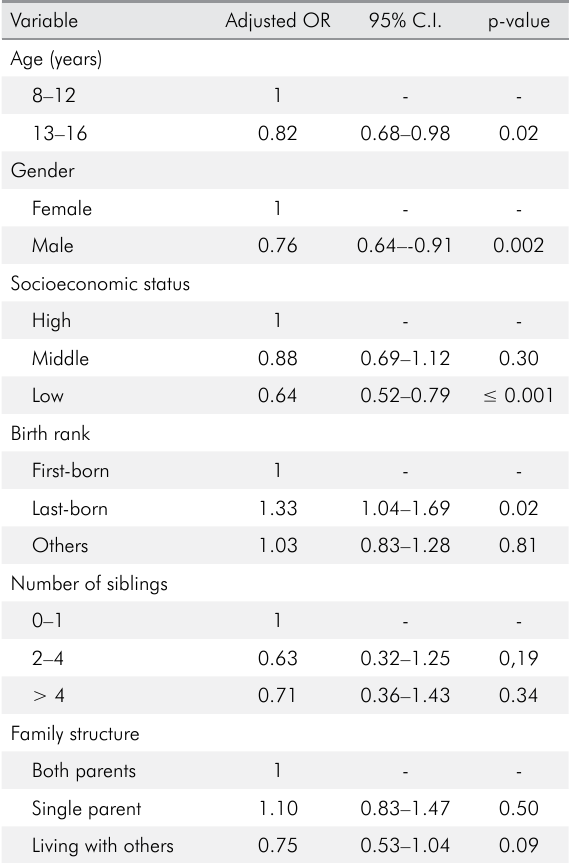
Table 3. Logistic regression determining the odds of having good oral hygiene among all study participants (n =